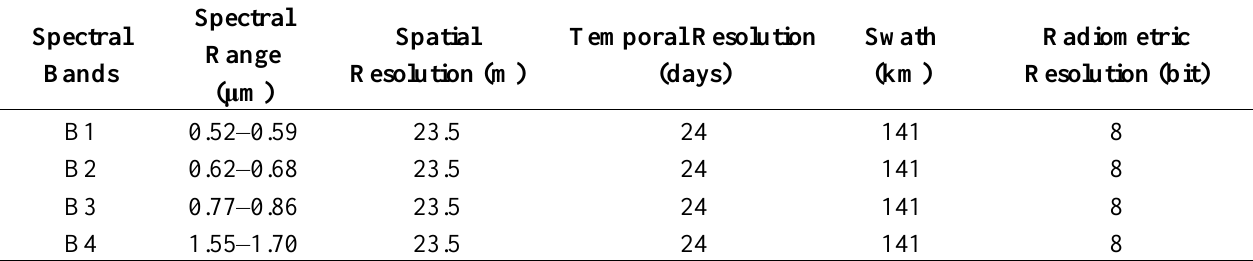
Table 1. Resourcesat/LISS-3 main